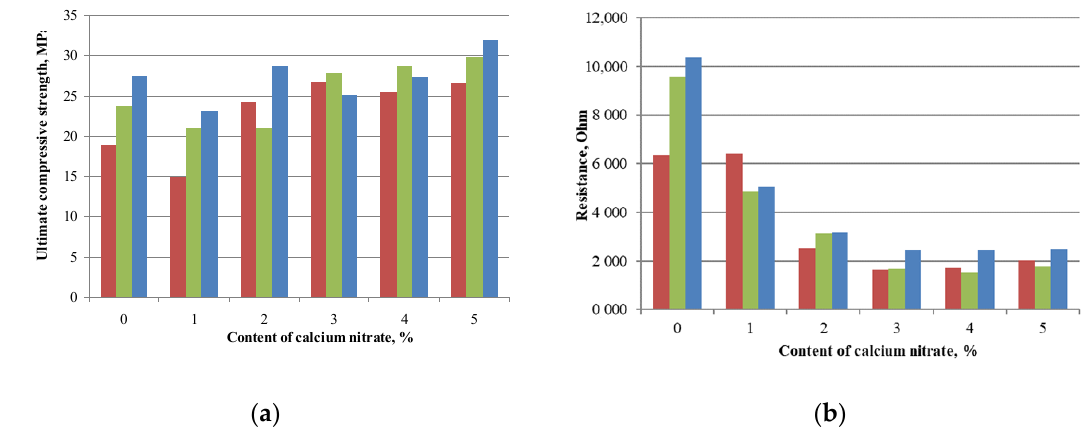
Figure 8. Influence of calcium nitrate amount on characteristics of sample with 7% of carbon nanotubes: ultimate compressive strength ‐ ( a ), electrical resistance ‐ ( b ).